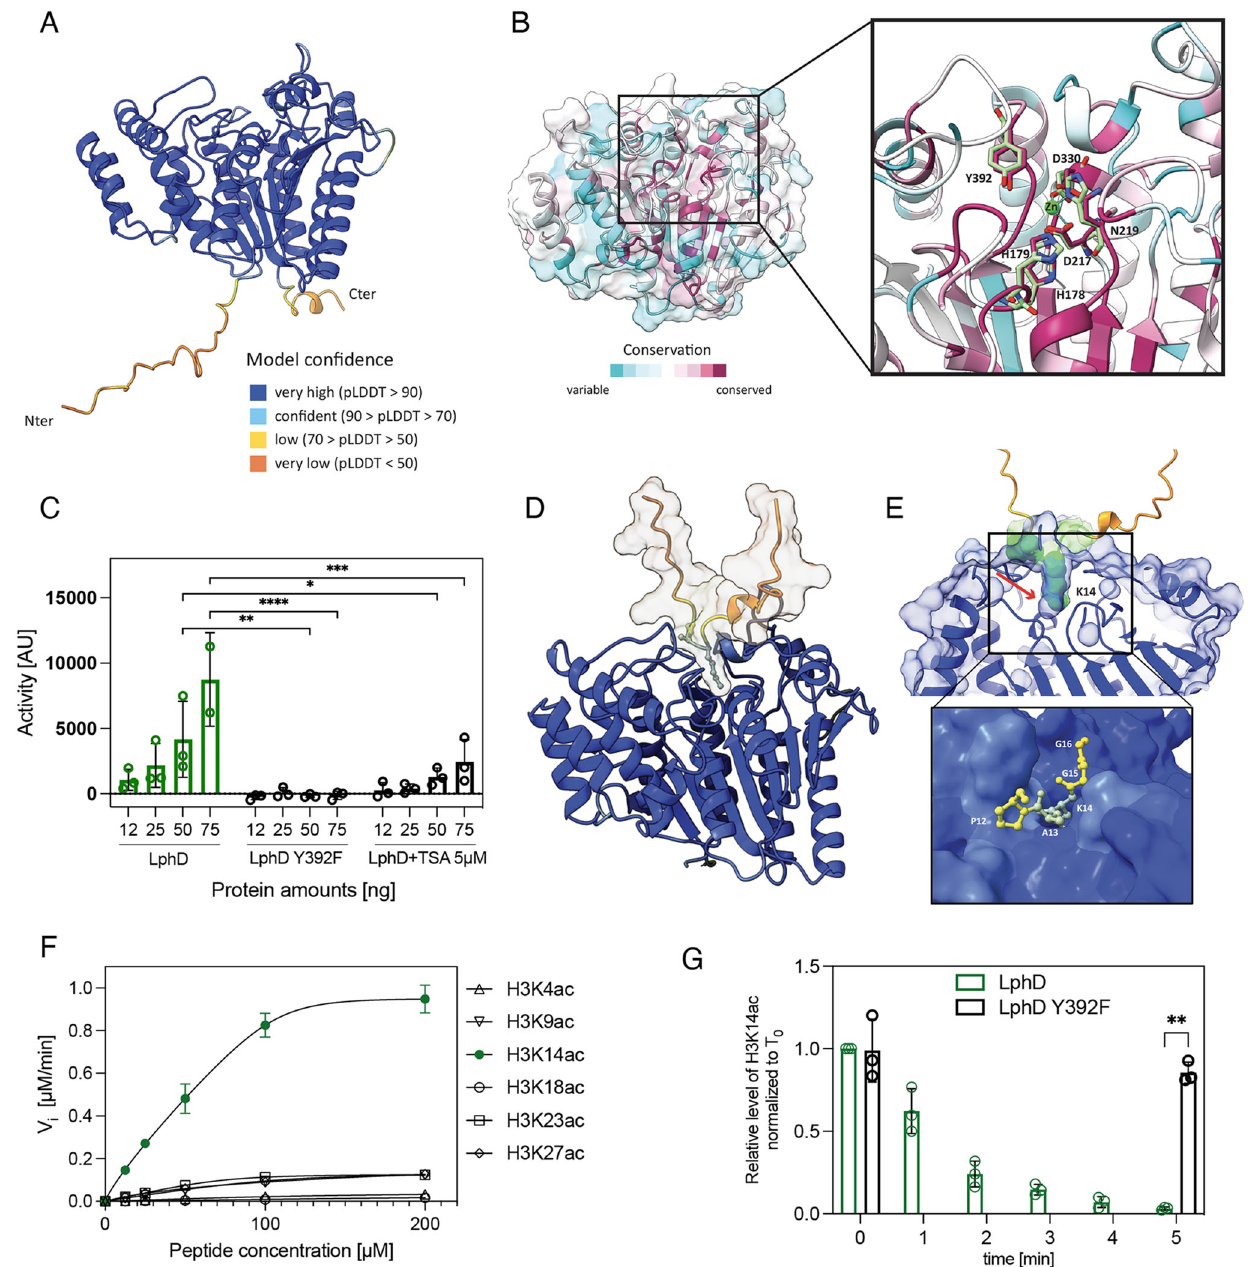
Fig. 1 | LphD has predicted structural similarity to eukaryotic HDACs and possesses deacetylase activity. A LphD model generated by AlphaFold v2.0.1. Insert : per-residue con fi dence score (pLDDT) produced by AlphaFold. B The conservation score between LphD and representative eukaryotic HDAC families mapped onto the LphD model. Insert : substrate binding groove with the catalytic residues (binding pocket residues and catalytic center) of LphD highlighted, colored according to conservation and HDAC6 colored green (PDB 5EDU). The catalytic zinc is shown from the HDAC6 structure. C Fluor de Lys® HDAC activity assay of LphD. Lysine deacetylase activity in vitro of increasing amounts of His- LphD and its catalytic inactive mutant (His-LphD Y392F). Control: 5 µ M of Tri- chostatinA(TSA)(HDACinhibitor).Dataarepresentedasmeanvalues±SDof n =3 independent experiments. For statistical analyses a two-way ANOVA was per- formed using Tukey ’ s multiple comparisons test (* p =0.0486, ** p =0.027, *** p =0.002, **** p <0.001). D LphD-H3 peptide complex generated by AlphaFold v2.0.1.TheH3peptideisrepresentedasasurface/cartoonmodel,K14,A15,andP16